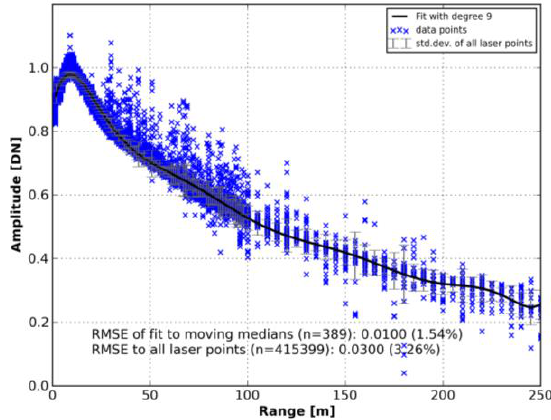
Figure 4. Vertical profile of boxplots of the training plot's corrected amplitudes (the 1 m² plot contains a sample of 80,132 points).